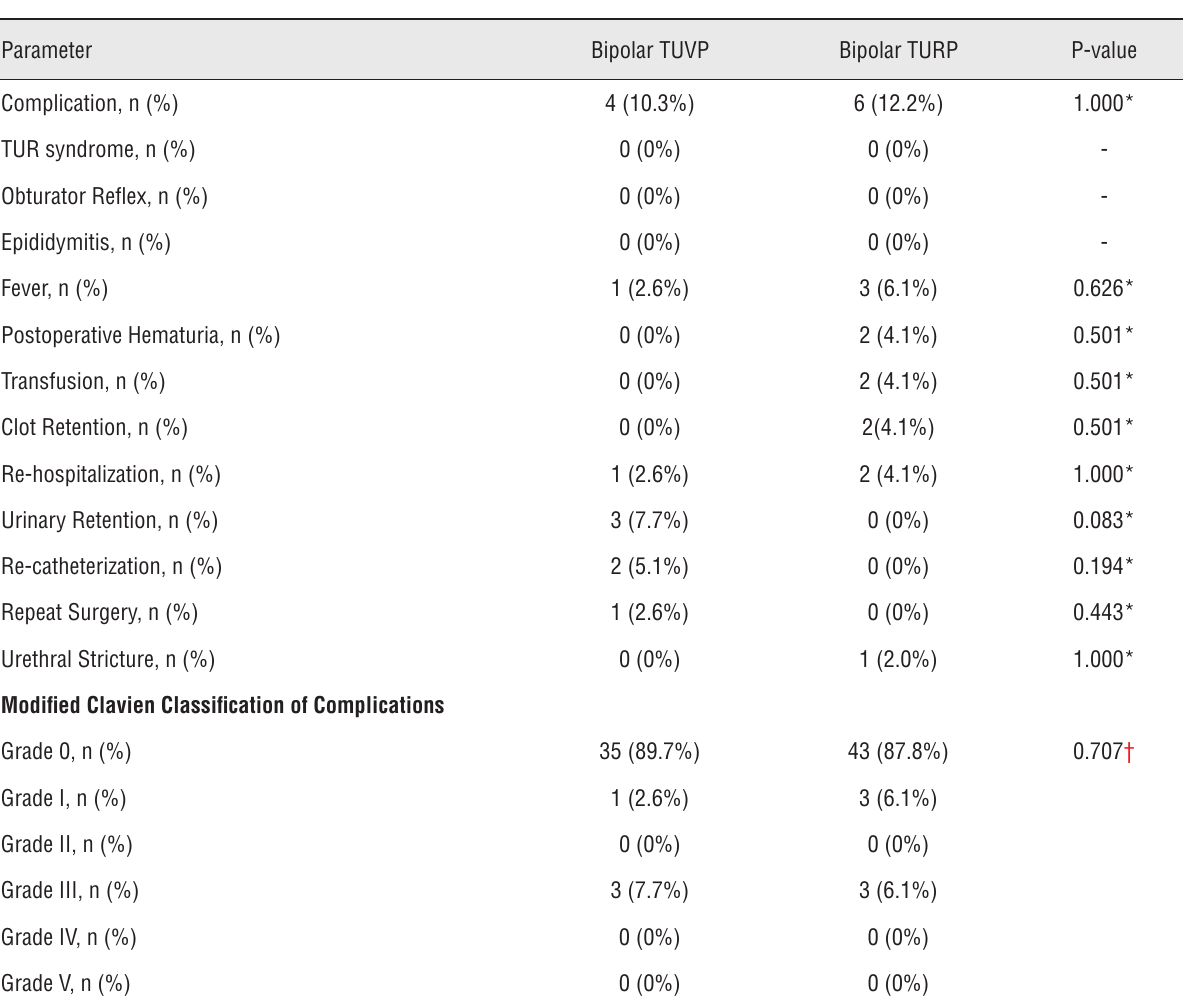
Table 3 - Complications in Bipolar TUVP and Bipolar TURP